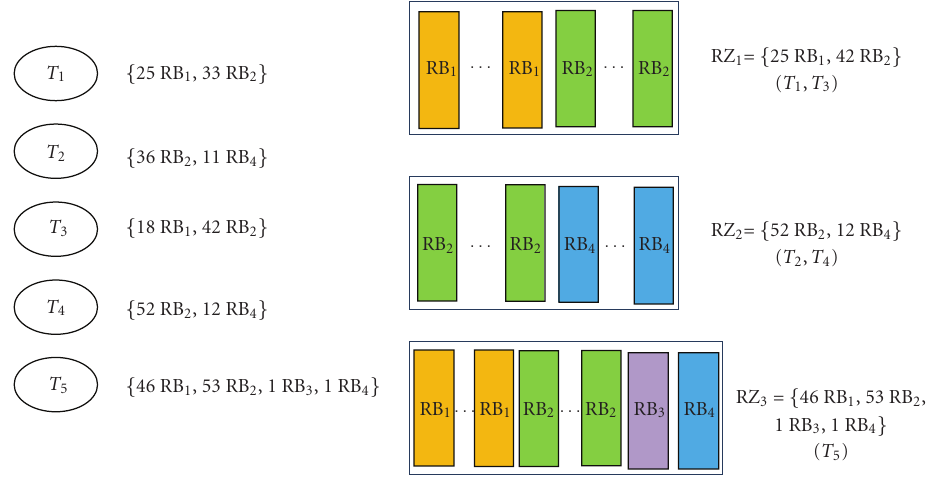
Figure 1: Example of RZ types search.